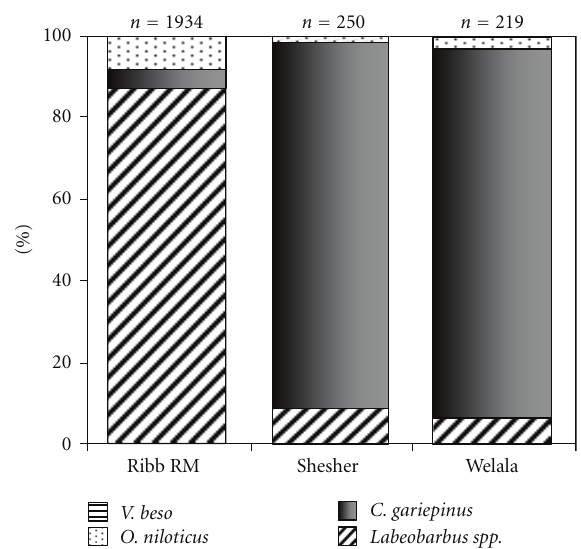
Figure 3: Percentage composition of fish collected at Ribb River mouth and its associated wetlands: Shesher and Welala. Data from all sites (for Shesher and Welala) and months pooled. “ n ” refers to the number of fish.